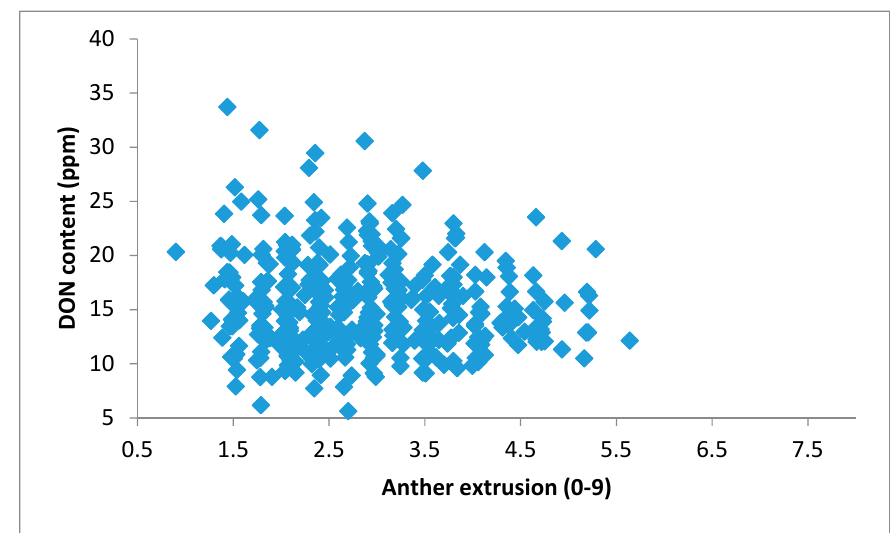
Figure 1. Distribution of BLUP values for anther extrusion in the North American AFRI CORE oat screening panel ( Left) and the Nordic oat screening panel ( Right ). Anther extrusion was scored on a 0–9 scale. Note the more limited range in the AFRI CORE.